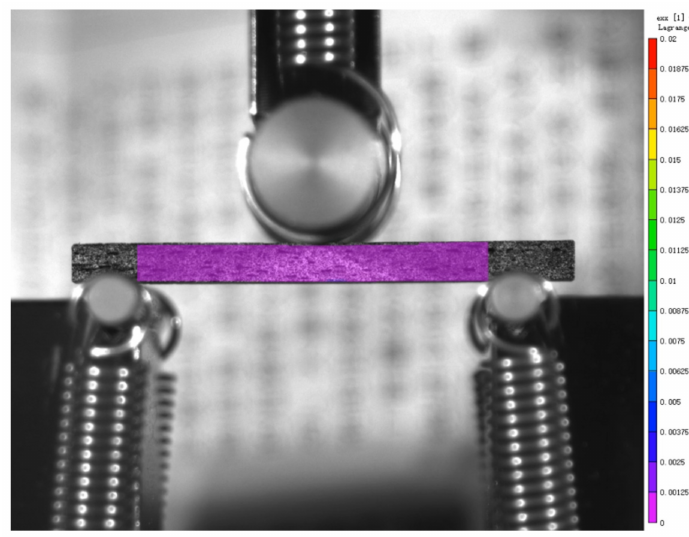
Figure 2. Experiment